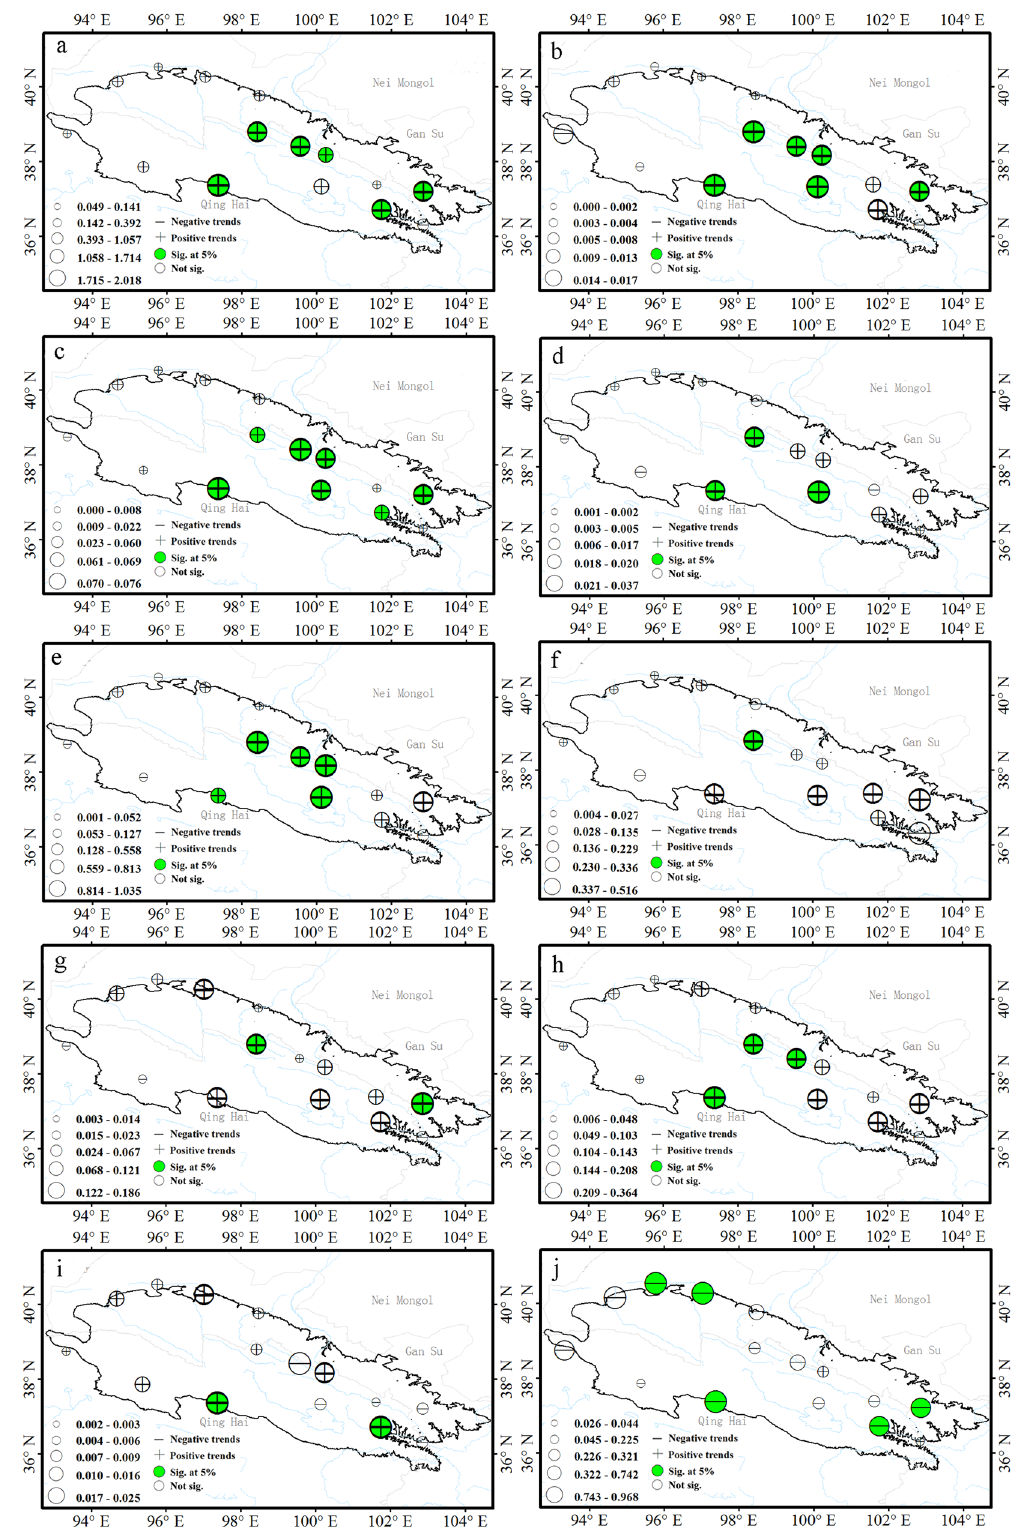
Figure 8. Spatial patterns of indices of precipitation extremes. Precipitation indices: wet day precipitation ( a ), simple daily intensity ( b ), heavy precipitation days ( c ), very heavy precipitation days ( d ), very wet day precipitation ( e ), extremely wet days precipitation ( f ), maximum 1-day precipitation ( g ), maximum 5-day precipitation ( h ), consecutive wet days ( i ), consecutive dry days ( j ). For description of indices, see Supplementary Table S1. The size of the circles is the degree of changing. Positive trends are shown as pluses, negative trends as minuses. A green symbol indicates significance at the 5%; a white symbol represents non-significant trends. The maps are generated with Arc Map Ver 10.1